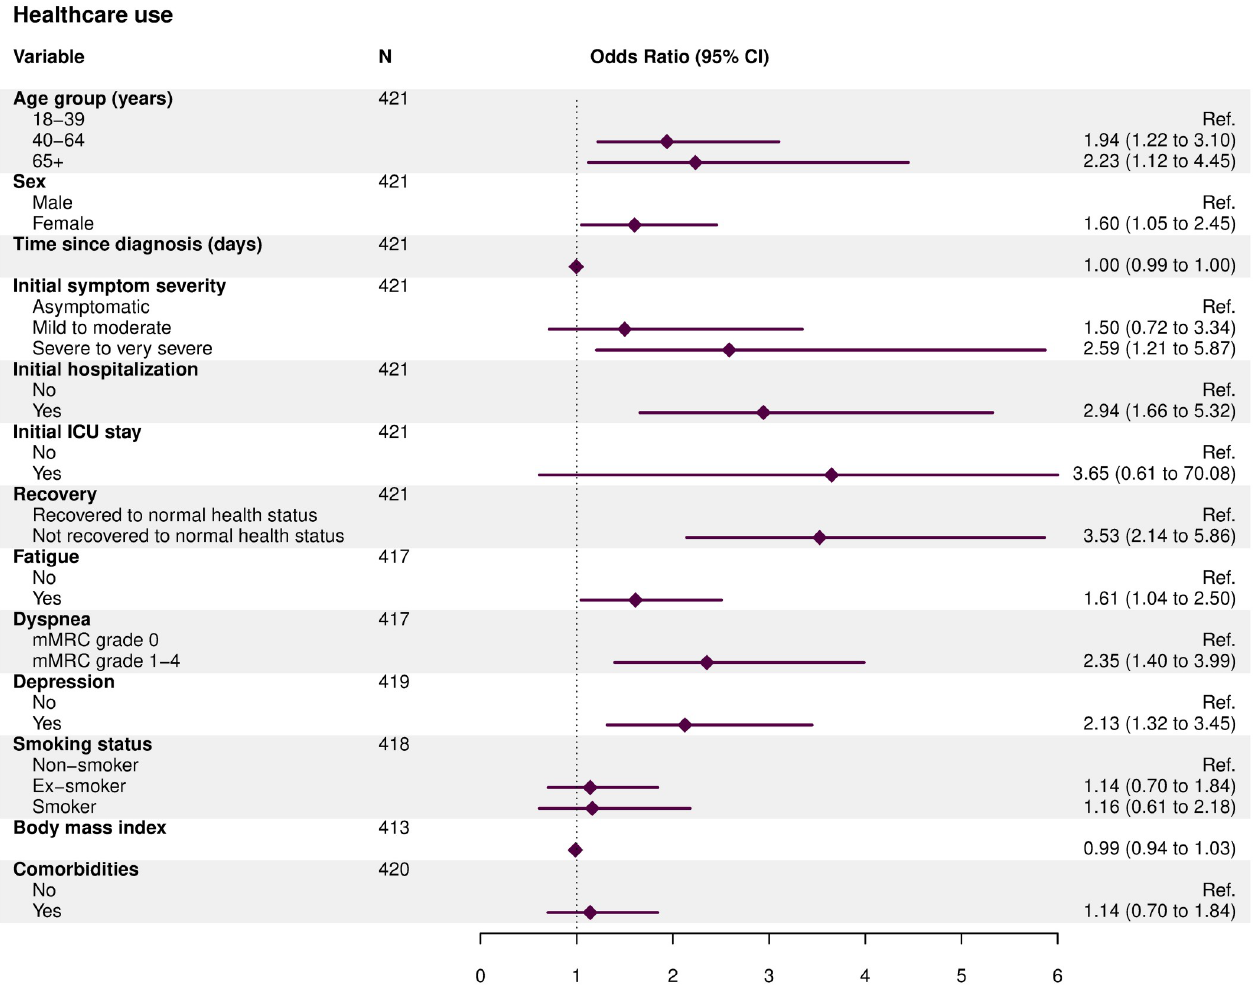
Fig 3. Associations for healthcare service utilization at six to eight months after SARS-CoV-2 infection. Fig 3 shows associations for having at least one further healthcare contact after initial COVID-19, based on multivariable logistic regression models adjusted for age, sex, initial hospitalization, and initial symptom